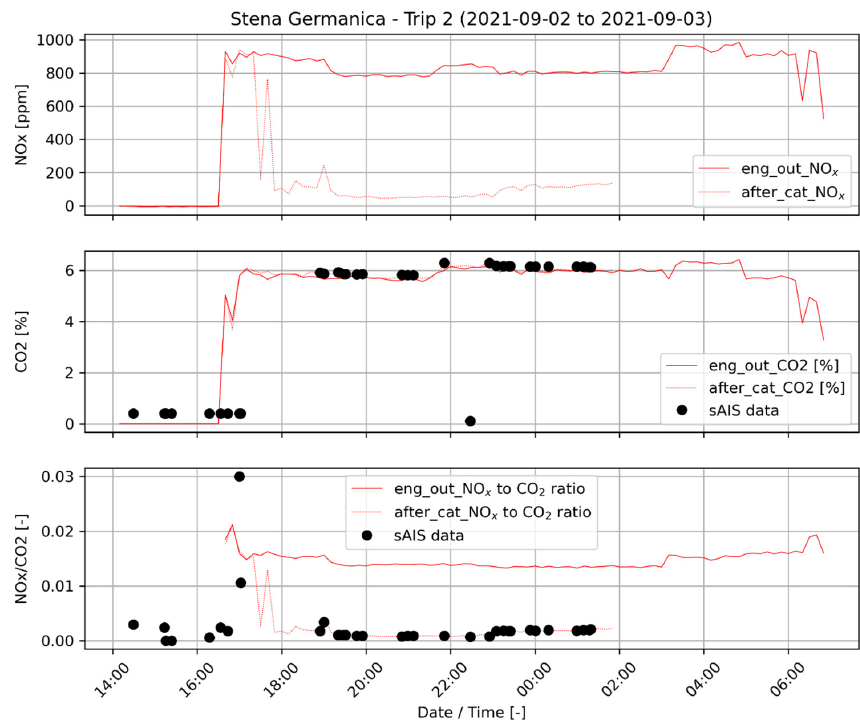
Figure 11. Comparison of SEMS 1 Hz data and S-AIS data from 2 September to 3 September 2021, where the S-AIS data transmission was